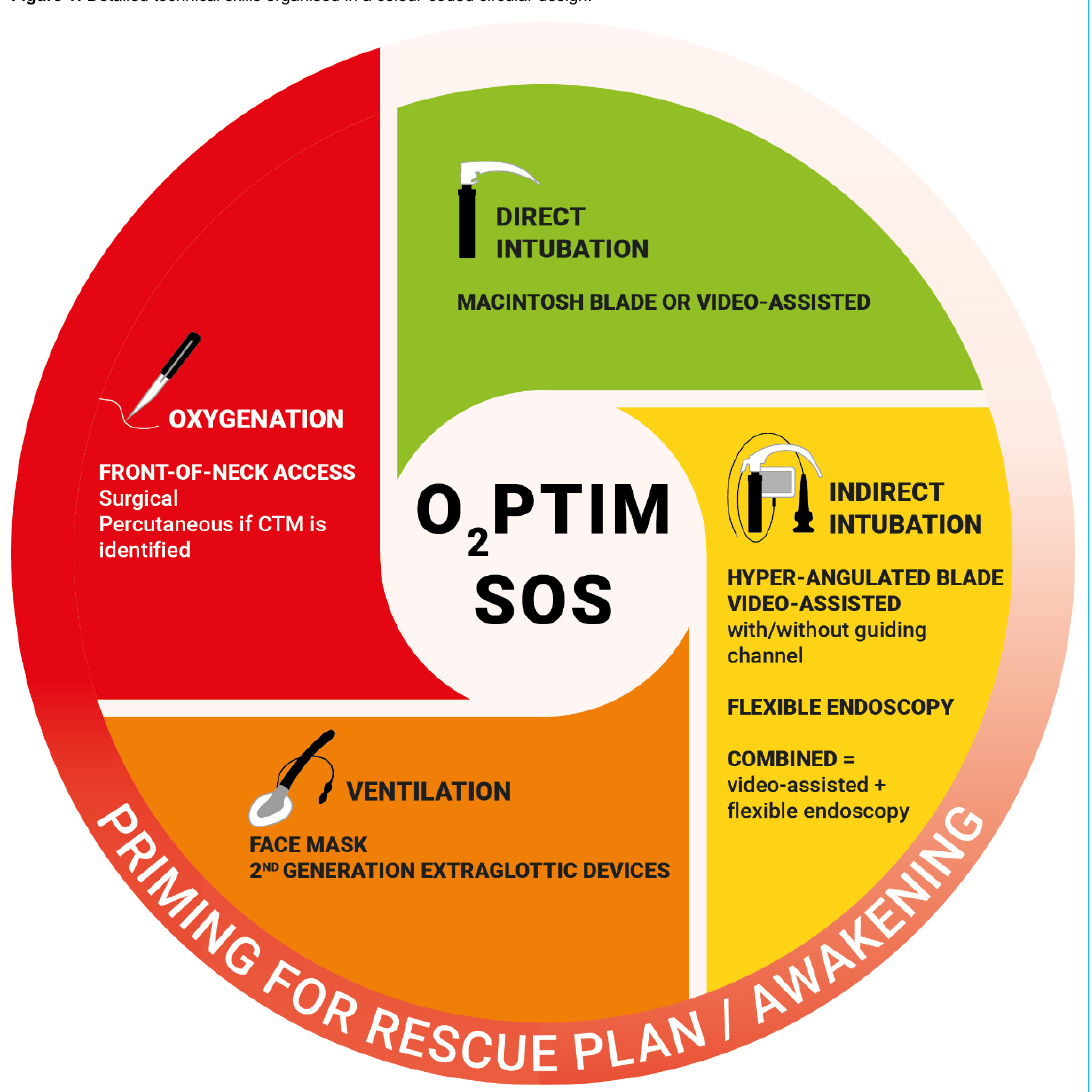
Figure 1: Detailed technical skills organised in a colour-coded circular